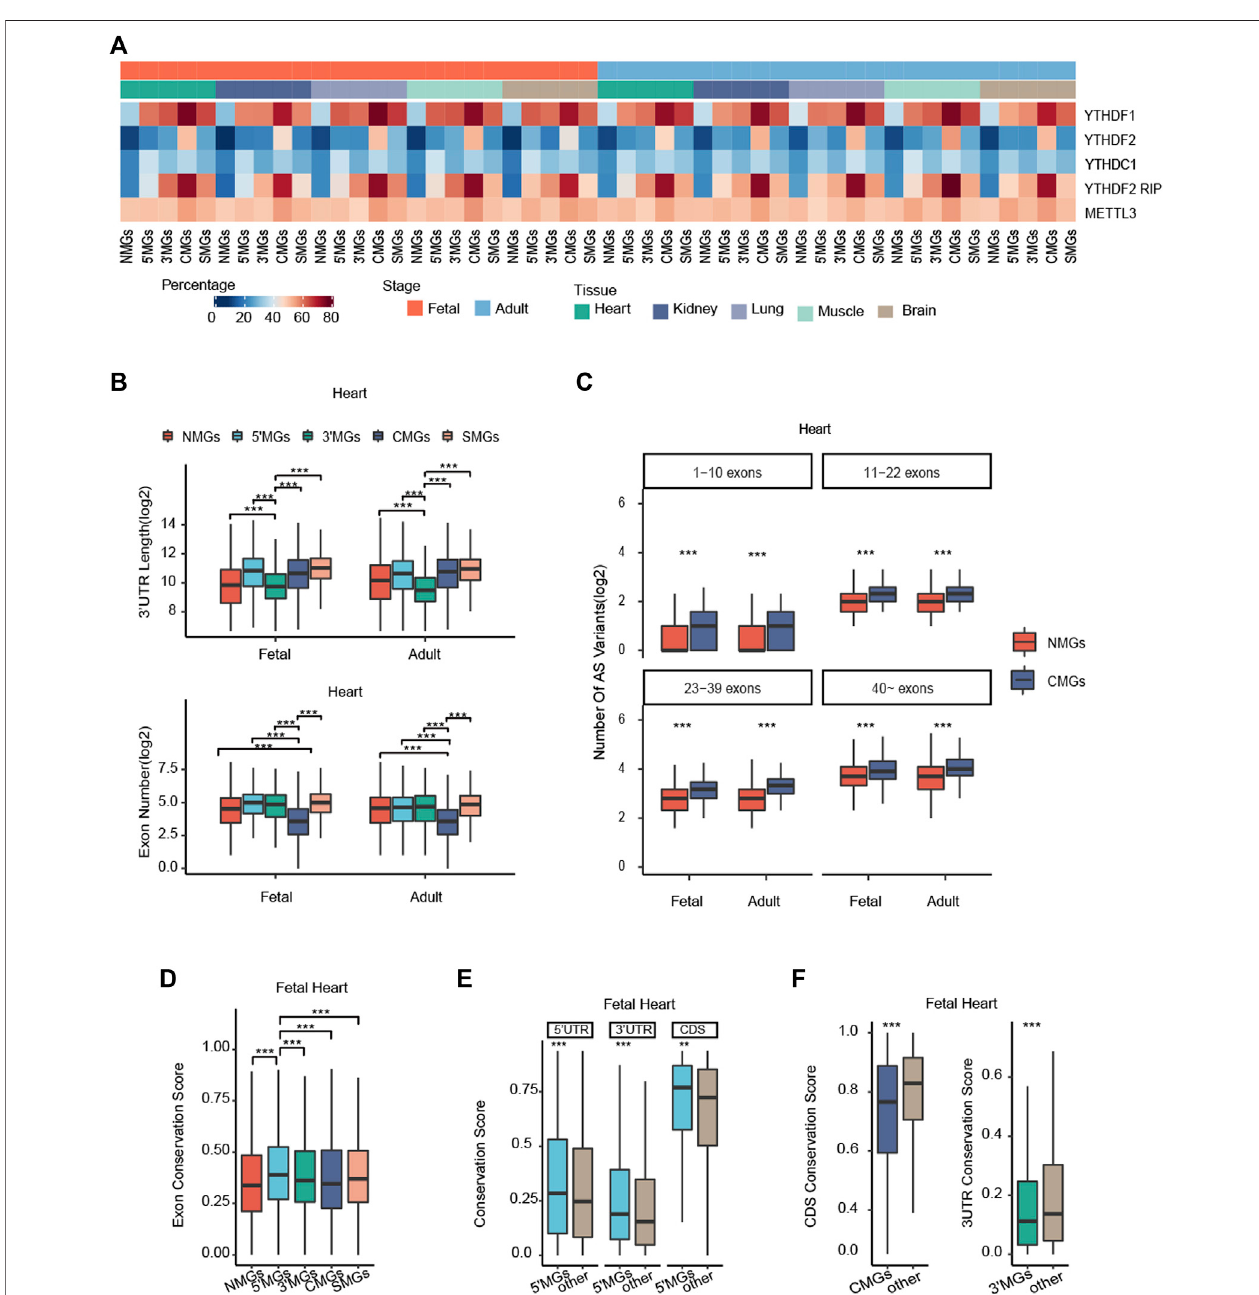
FIGURE 3 | Potential mechanisms associated with different m6A topologies among different gene groups. (A) Heatmaps showing the distribution of YTHDF1 , YTHDF2 , YTHDC1 , YTHDF2 (RIP),and METTL3 targetedgenesineachgroupacrossallhumantissuesinfetalandadultstages.ColorsrepresentthepercentageofWER targeted genes. (B) The 3 ′ UTRs length and exon number of each gene group among human heart tissue in fetal and adult stages (Kruskal – Wallis rank-sum test, *** p value < 0.001). (C) The number of alternative splicing (AS) variants in NMGs and CMGs with distinct exon numbers in human fetal and adult heart tissue (Wilcoxon rank-sum test, *** p value < 0.001). (D) The exon conservation score of fi ve gene groups in fetal heart tissue (Kruskal – Wallis rank-sum test, *** p value < 0.001). (E) The conservation score of 5 ′ UTRs, 3 ′ UTRs, and CDS among 5 ′ MGs and other group genes with m6A methylation of human fetal heart tissue (Wilcoxon rank-sum test, *** p value < 0.001,** p value < 0.01). (F) TheCDS conservationscore ofCMGsand othergroup genes withm6A methylation (Left); the3 ′ UTRs conservationscore of3 ′ MGs and other group genes with m6A methylation in human fetal heart tissue (Right) (Wilcoxon rank-sum test, *** p value < 0.001).